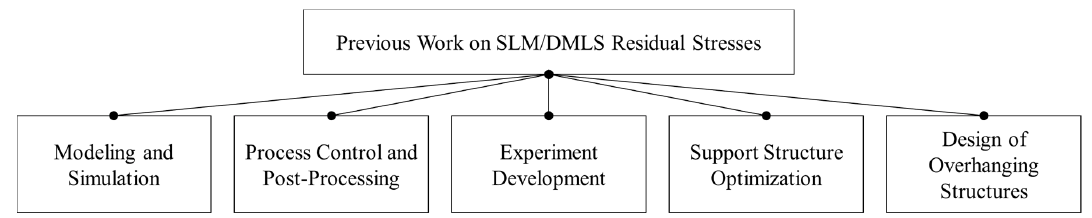
Figure 6. Previous work categories.